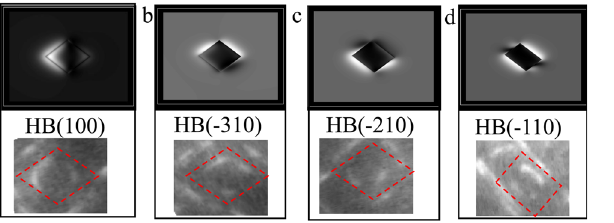
Fig. 7 Comparison between the simulated TEM images and in situ images for a <100> loop. The loop is located on different habit planes: a (100), b (-310), c (-210) and d (-110). The top images are results simulated by TEMACI program 19 – 21 , and the bottom images are results taken from the in situ observation from Supplementary Movie 3. The shape of loop is marked by the red dot rhombus and